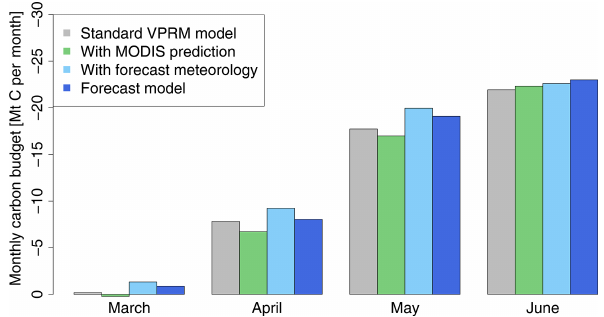
Figure 11. Monthly carbon budget from March to June for original and forecast model for the European domain. The overall forecast flux budget is close to the original model, indicating the forecast flux model is appropriate for use in the GHG concentration fore- casting